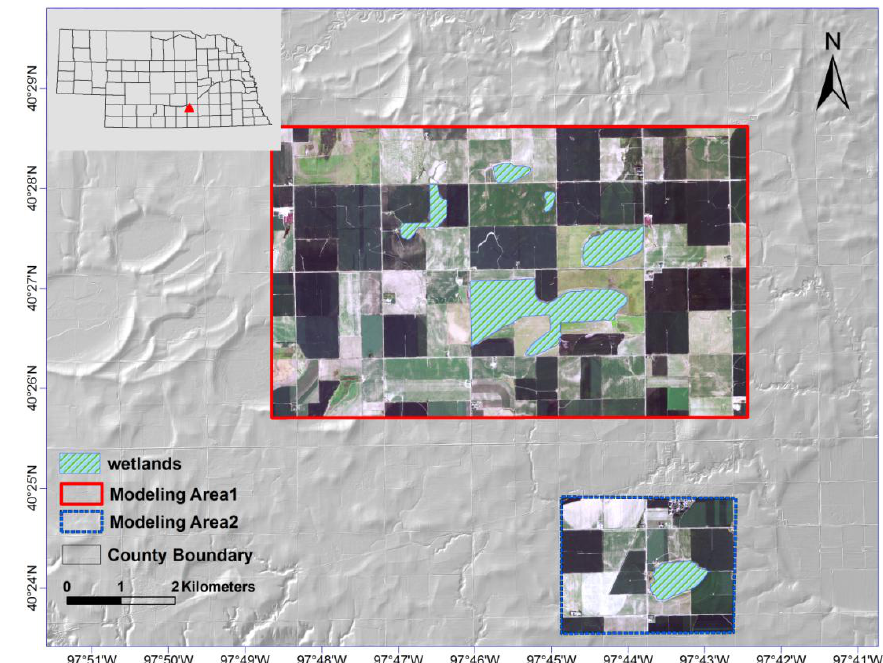
Figure 3. Locations of wetlands and the study